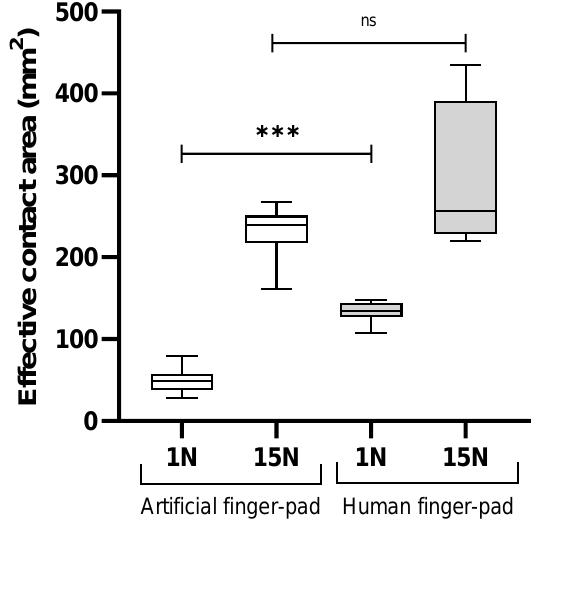
Figure 3. Topological quality of artificial finger-pad. ( a ) Entire artificial finger-pad, ( b ) magnified view of portion showing topology (×20), and ( c ) comparative ink prints from same region of real finger and artificial finger from human subject. Note only portion of entire print is shown for data protection purposes.